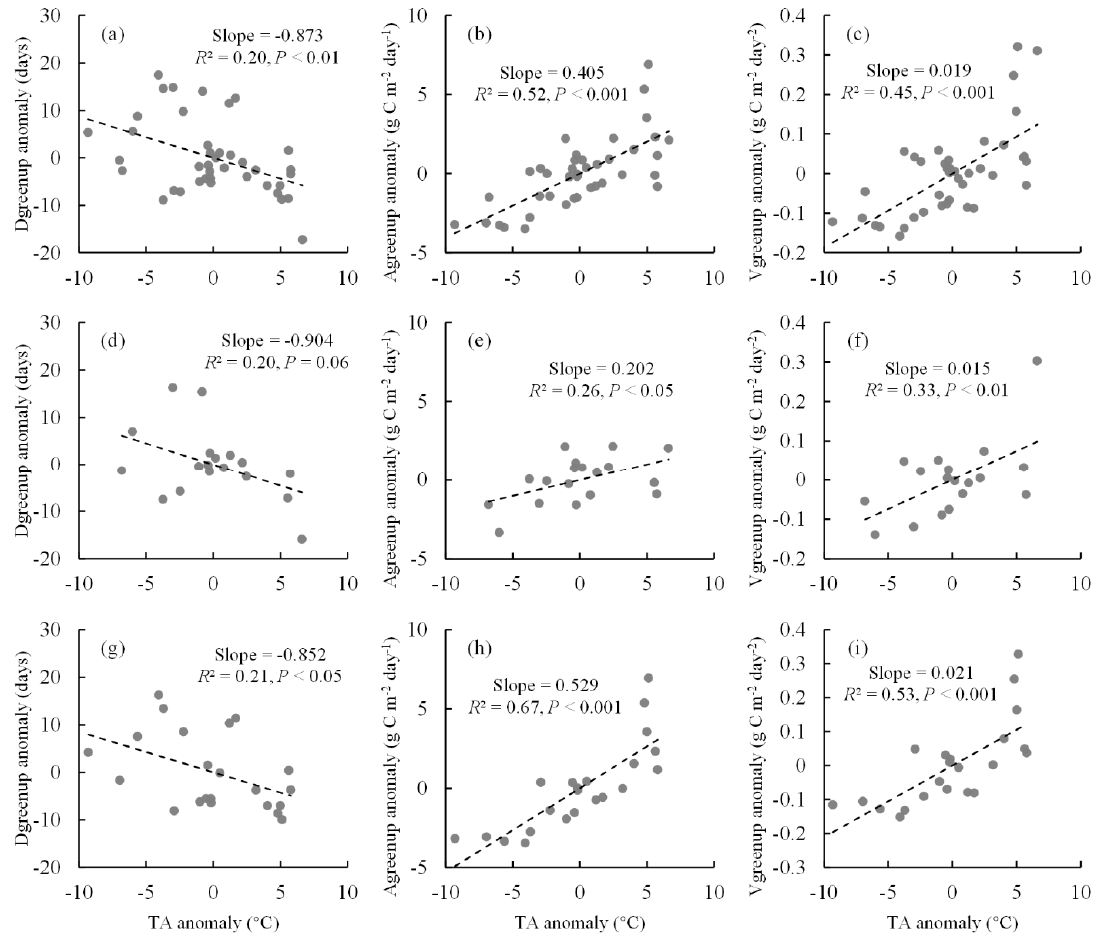
Figure 5. The spatial relationships between temperature anomalies and Dgreenup anomalies, Agreenup anomalies, and Vgreenup anomalies. ( a − c ) The spatial relationships across all sites in both Europe and North America; ( d − f ) the spatial relationships across all sites in Europe; ( g − i ) the spatial relationships across all sites in North America.